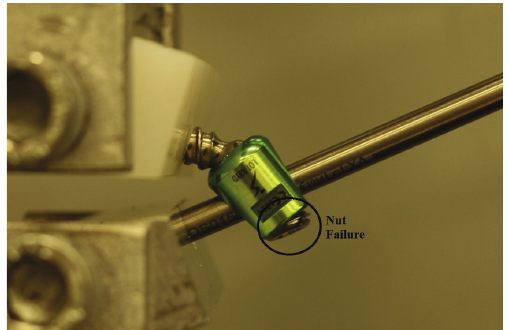
Figure 7: Nut failure before screw cut-off.